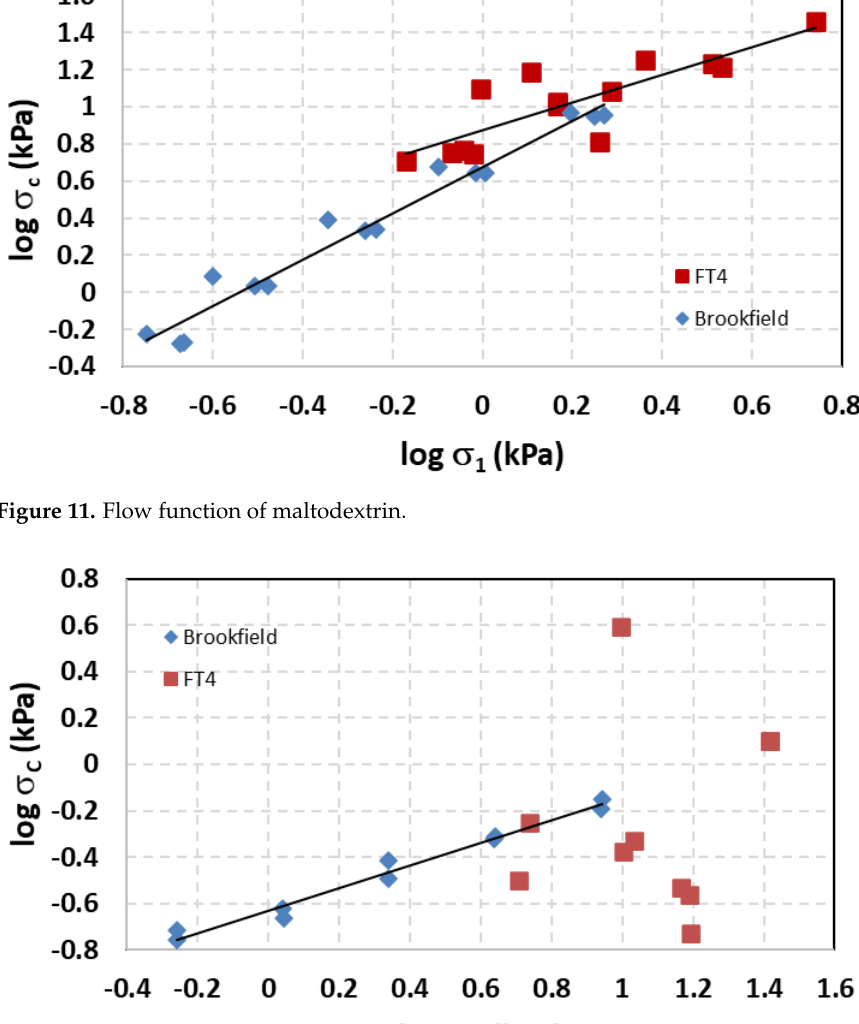
Figure 10. Flow function of lactose.